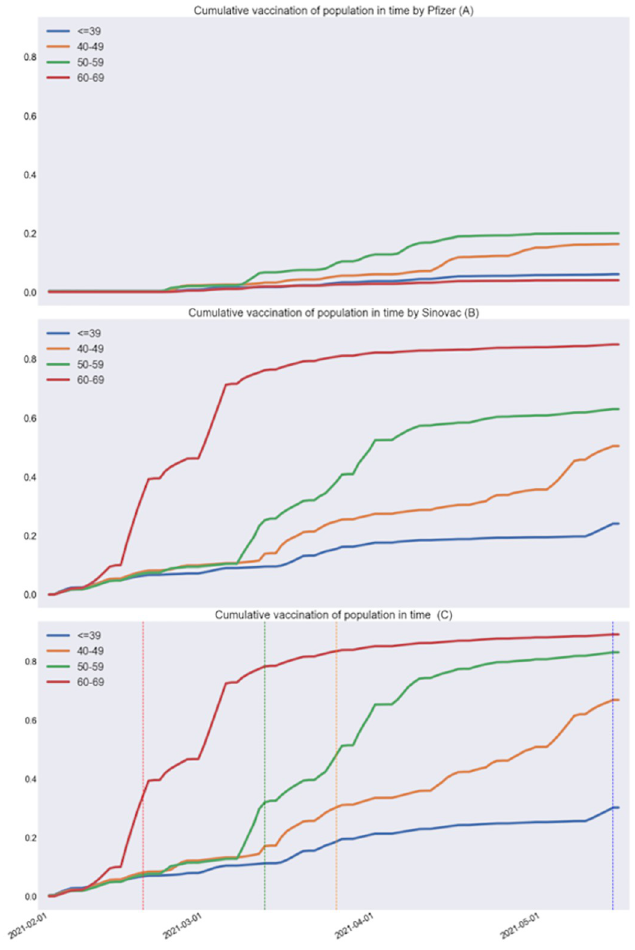
Fig 3. Massive vaccination rollout. For each age-bracket, curves in (A) and (B) depict the cumulative vaccination (first doses) for the mRNA vaccine from Pfizer and the inactivated virus vaccine from Sinovac, respectively, as a percentage of the eligible population. (C) depicts the total cumulative vaccination, where for each age bracket, a colored vertical line indicates the date on which accumulative vaccination reached 30% of the eligible